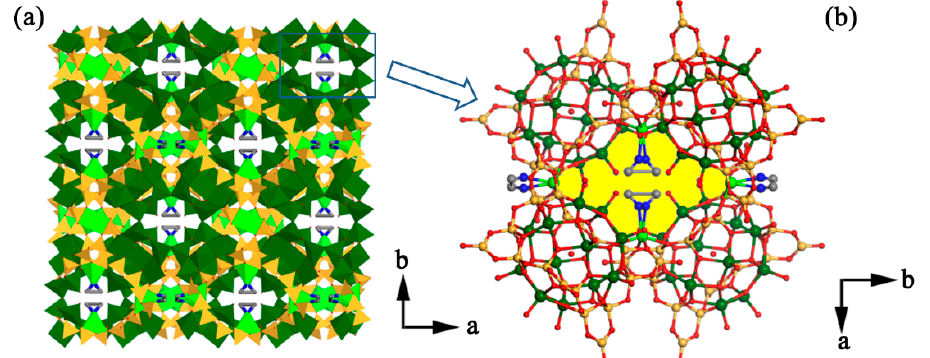
Figure 4. ( a ) View of the 3-D open-framework of 1 ; ( b ) view of the plane-shaped channels in 1 . Color code: O, red; V, dark green; B, yellow; Zn, green.